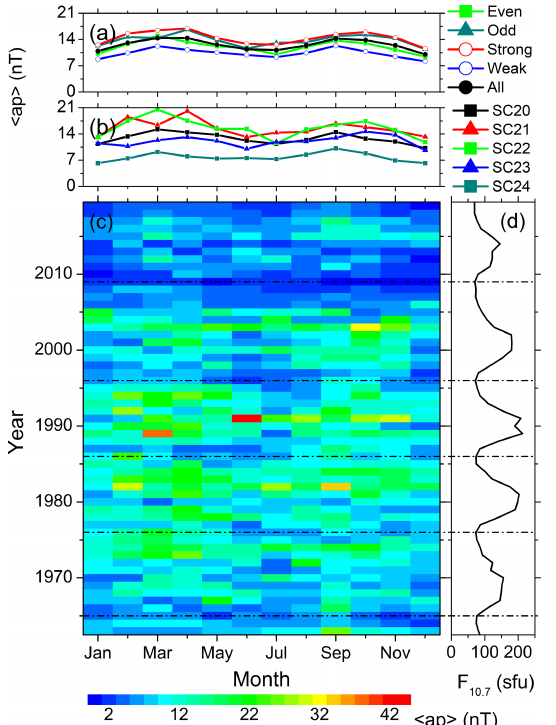
Figure 8. Geomagnetic ap index variation from 1963 to 2019. The panels are in the same format as in Fig. 7.